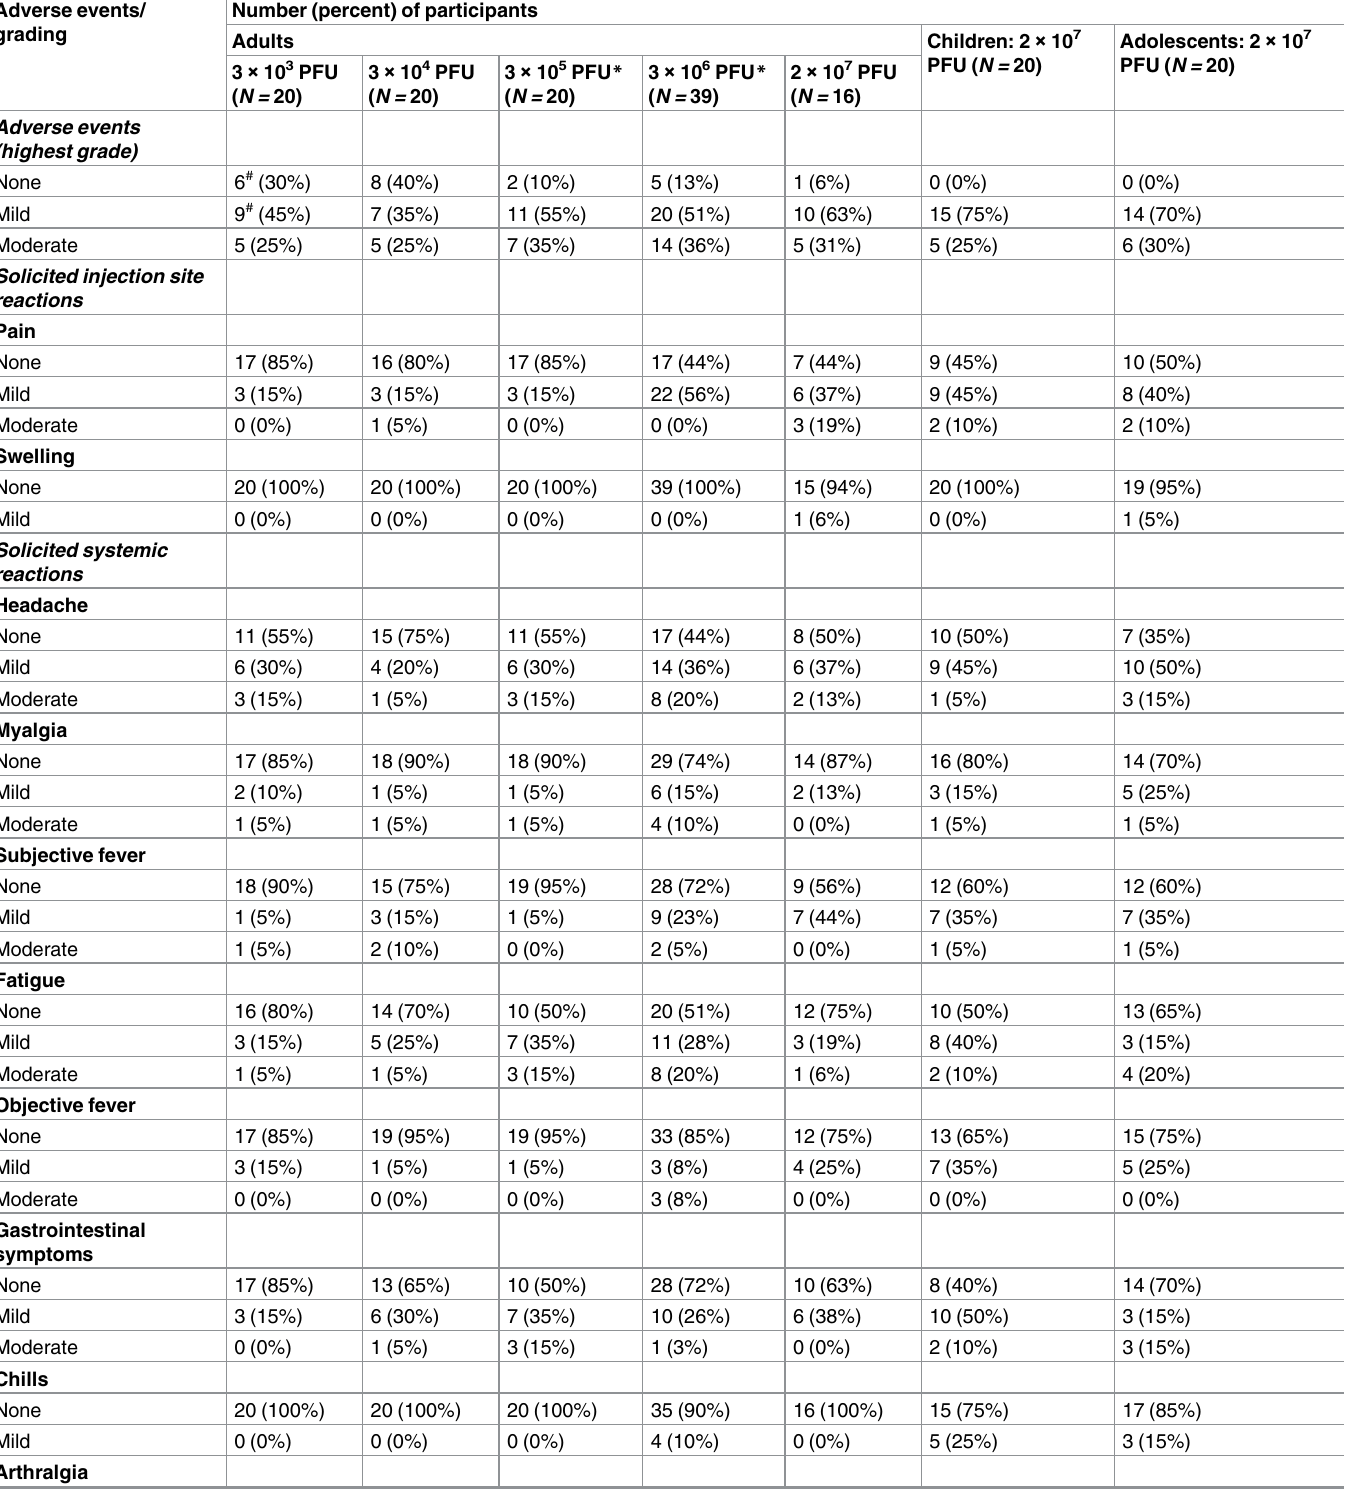
Table 2. Reactogenicity to rVSV Δ G-ZEBOV-GP vaccine until day 28 post-vaccination. Adverse events/